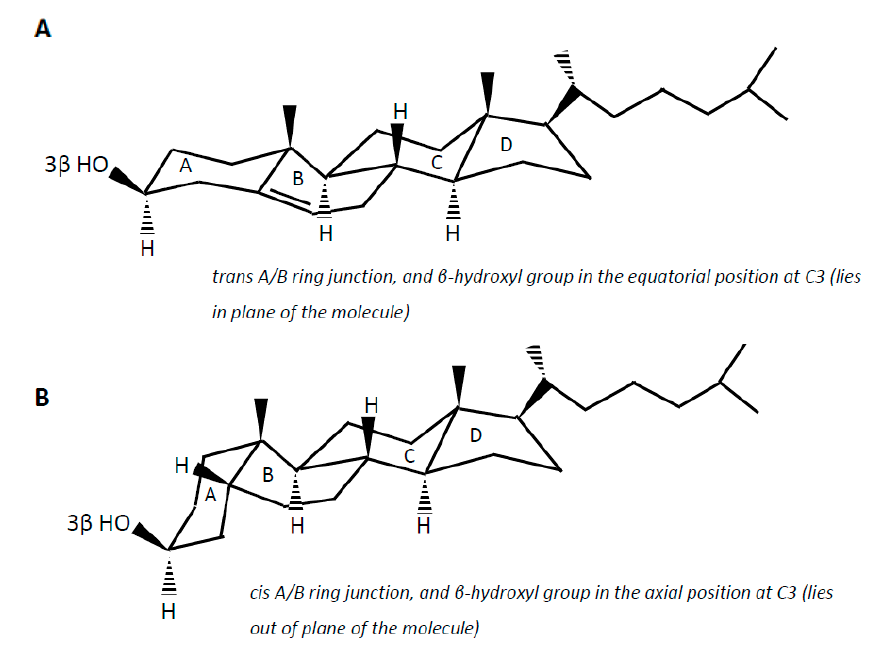
Figure 2. Planar representation of cholesterol ( A ) and coprostanol ( B ).